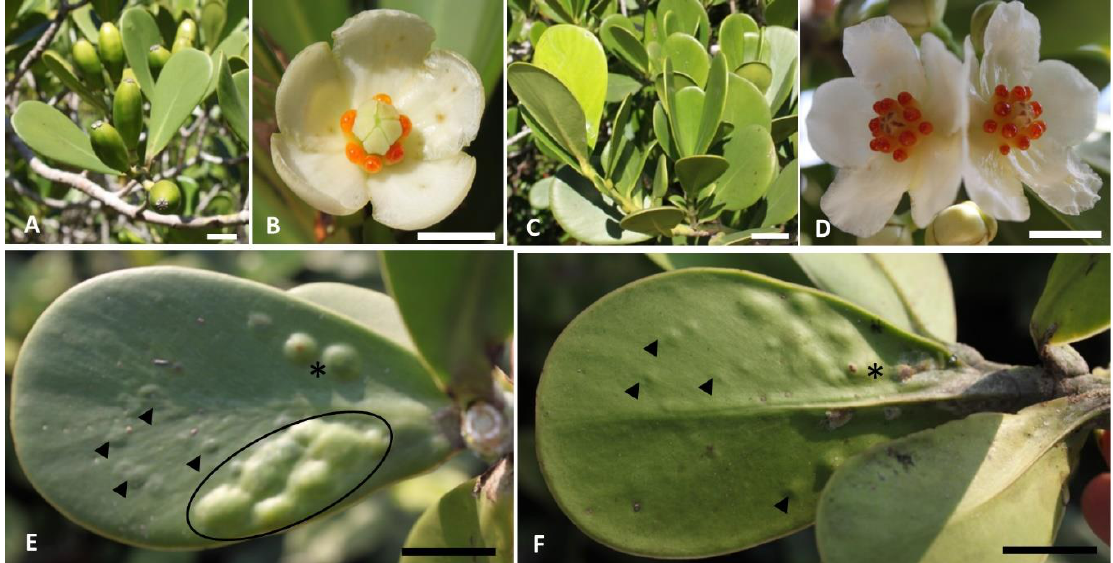
Figure 1. C. fluminensis. Female ( A , B ) and male individuals ( C – F ) with leaf galls induced by Parazalepidota clusiae (Cecidomyiidae) ( E , F ). ( A ) Non-galled leaves and fruits in the initial stage of development. ( B ) Female flower. ( C ) Non-galled leaves of a male individual. ( D ) Male flowers. Note the resiniferous stamens. ( E ) Adaxial surface of the galled leaf in different stages of development. Note the beginning of surface hypertrophy in initial stages (arrowhead), mature adjacent galls forming a continuous hypertrophied gall system (circle), and pre-senescent isolated galls (*). ( F ) Abaxial surface of the galled leaf. Note the beginning of surface hypertrophy in initial stages (arrowhead) and development of the exit channel in pre-senescent galls (*). Bars: ( A – F ) = 1